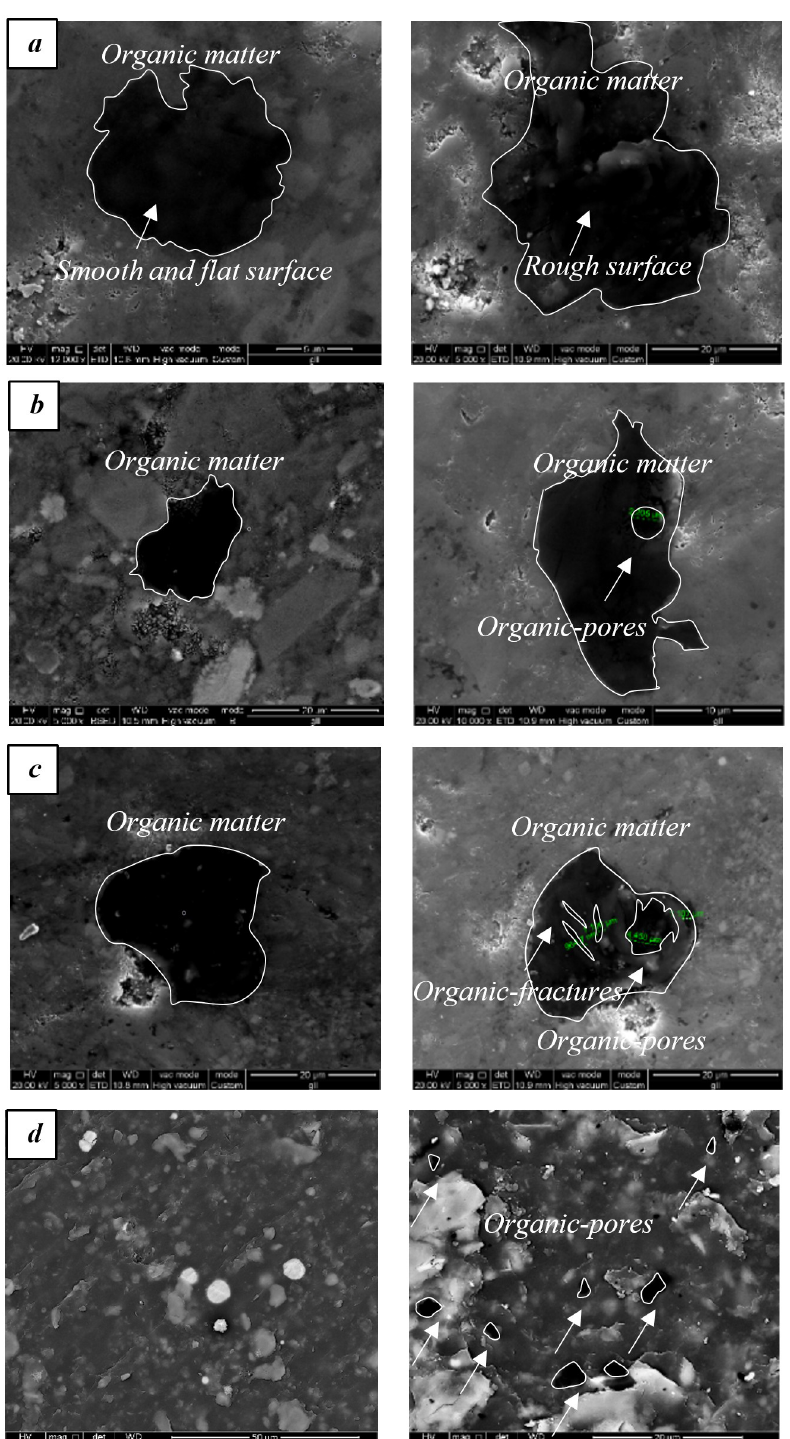
Fig 9. The SEM images obtained before and after 5 min of electromagnetic radiation. In these figures, the organic pores/fractures are highlighted in circles.